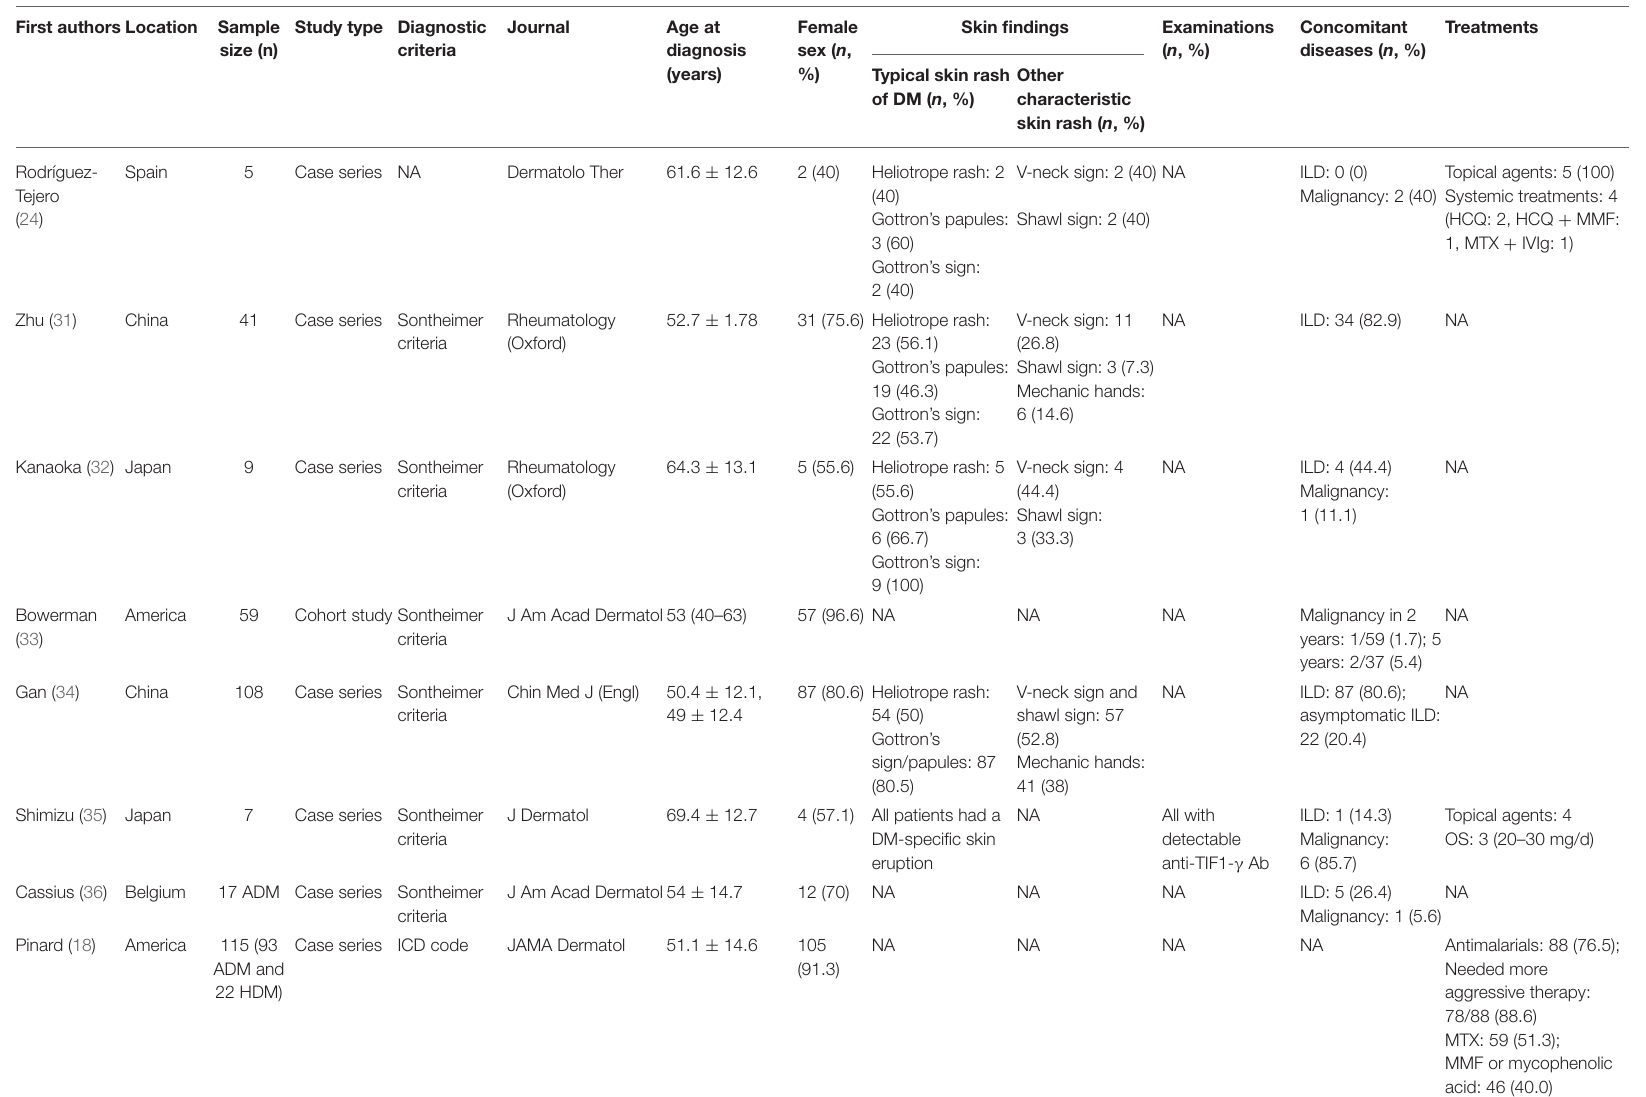
TABLE 3 | Clinical information of patients with clinically amyopathic dermatomyositis from previous studies. First authors Location Sample Study type Diagnostic size (n)